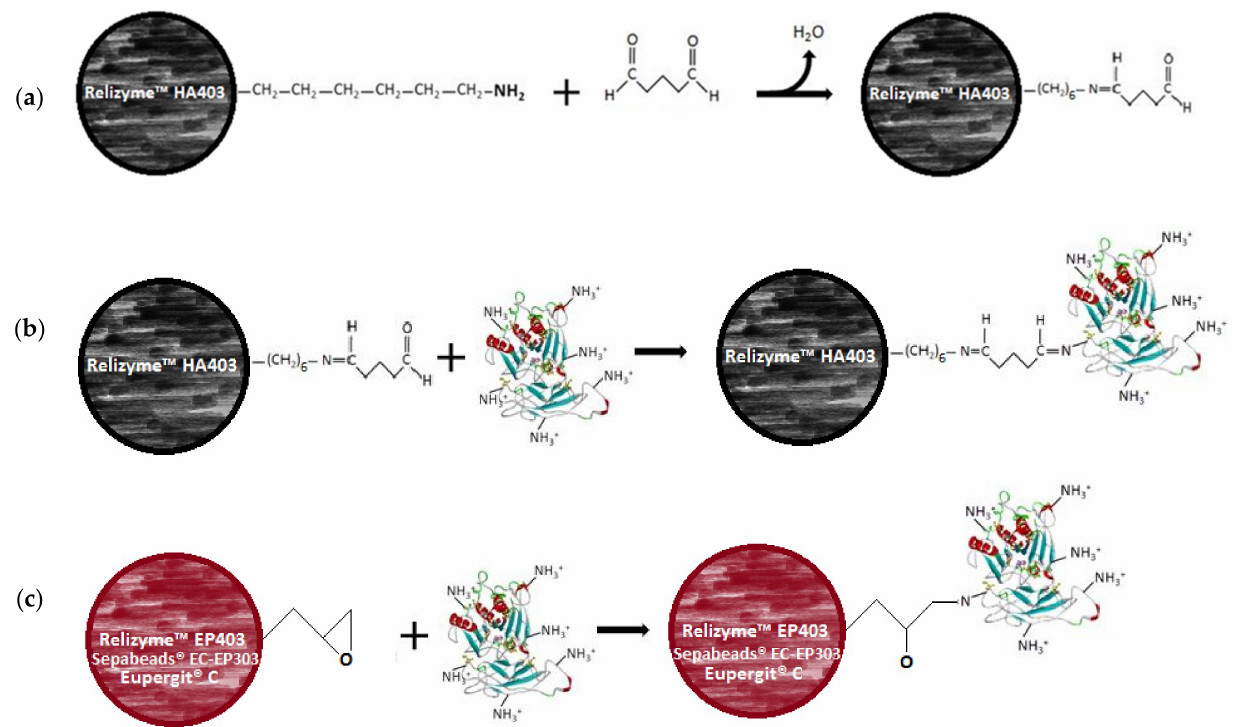
Figure 1. ( a ) Activation of ReliZyme™ HA403 support particle with glutaraldehyde. The support has a hexamethylamine arm that reacts with one of the aldehyde groups of the glutaraldehyde, releasing a water molecule in the reaction and leaving the support particle activated with the glutaraldehyde bound; ( b ) Immobilization of the enzyme via external amino groups (the N-terminus amino in particular) to epoxide groups on support surface; ( c ) Immobilization of the enzyme by Schiff-base formation between aldehyde groups on the support (provided by glutaraldehyde) and external amino groups on the enzyme (usually, the N-terminus amino group at neutral